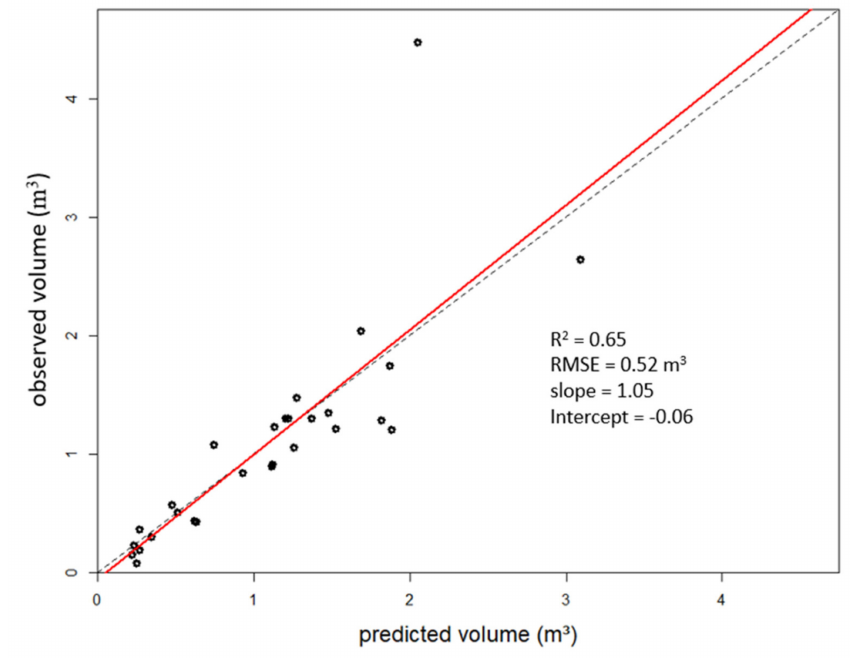
Figure 4. Predicted versus observed volume (m 3 ) for the final random forest model. The dashed black line is the 1:1 line; the solid red line is the regression line.